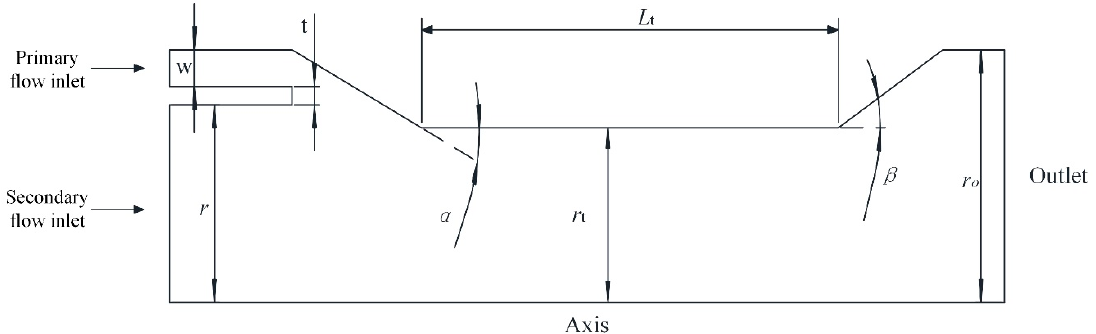
Figure 2. The computational domain.